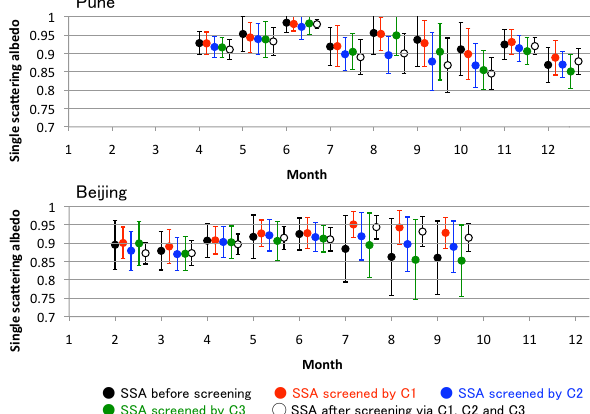
Fig. 14. Monthly mean and standard deviation of SSA at λ = 0 . 5µm before (black) and after (white) screening by all conditions of C1, C2, and C3, and after screening by each condition (C1, C2 or C3) individually (each screened result by C1, C2, or C3 are shown by red, blue, and green, respectively). The top panel shows the result at Pune in 2008 and the bottom panel shows the result at Beijing in